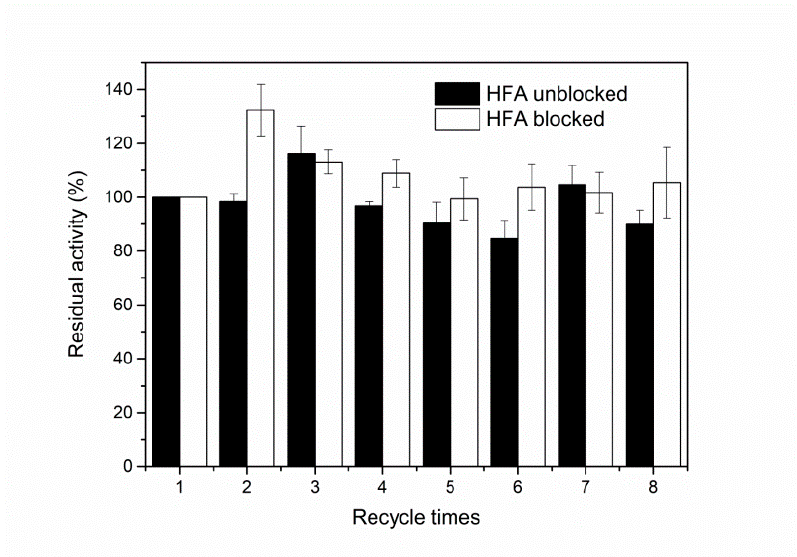
Figure 9. Reusability of immobilised